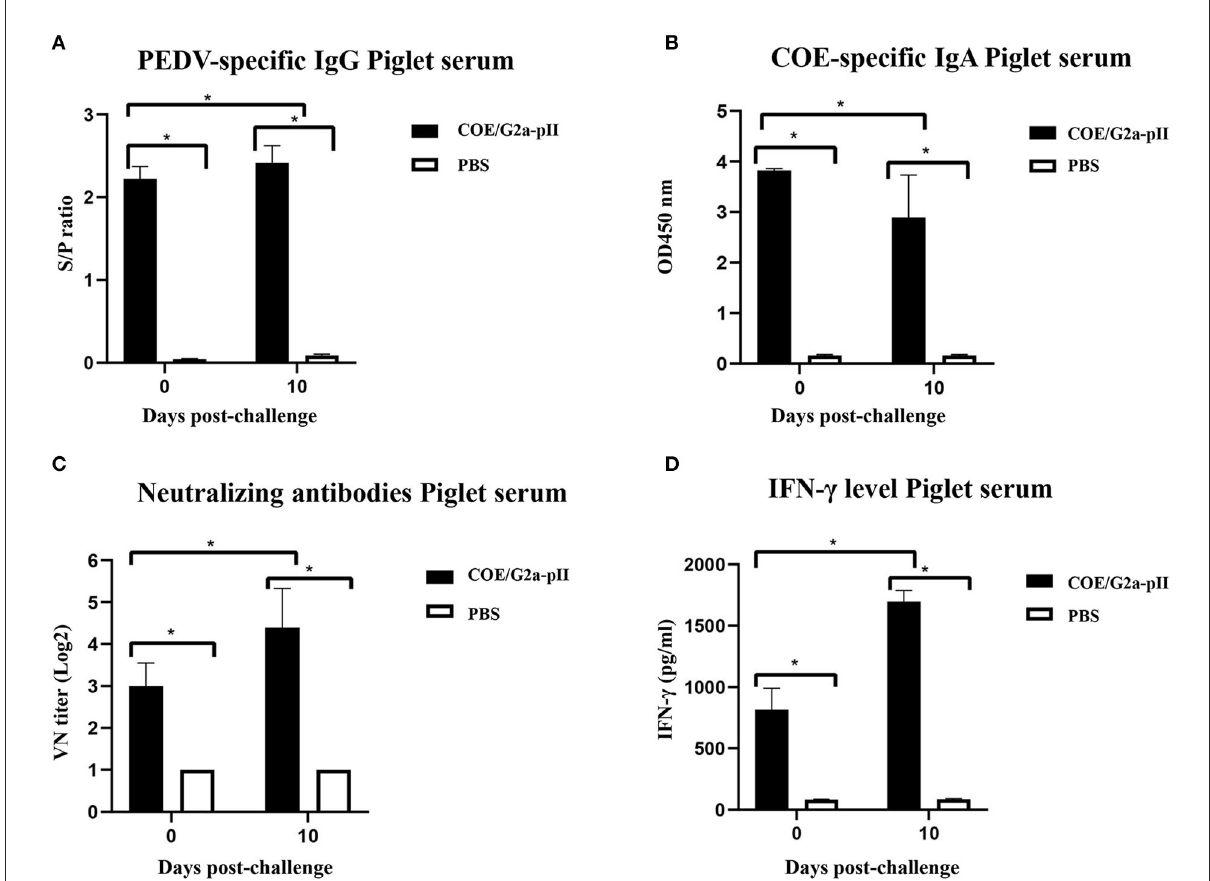
FIGURE3 Passive transfer of antibodies and cytokine from sows to piglets at the days 0 and 10pc. Data are presented as mean ± standard deviation (SD). * indicates a statistically significant difference ( p < 0.05). (A) PEDV-specific IgG antibodies in piglet sera from sows ( n = 1 per group) vaccinated with COE/G2a-pII, or PBS were measured by a commercial ELISA kit. An S/P ratio > 0.35 was defined as positive with a PEDV-specific IgG antibody. (B) COE-specific IgA antibodies in piglet sera ( n = 8 for COE/G2a-pII group and n = 2 for PBS group) were evaluated by an ELISA using SEC-purified COE/G2a-pII as antigen. (C) Neutralizing antibodies in piglet sera were analyzed by the virus-neutralizing assay. The highly virulent NAVET/PEDV/PS6/2010 strain (200 TCID50/0.1ml) was used for the assay. A VN titer ≥ 8 was defined as positive with neutralizing antibody against PEDV. (D) IFN- γ levels in piglet sera were measured based on the standard curve of recombinant porcine IFN- γ standard in a commercial ELISA